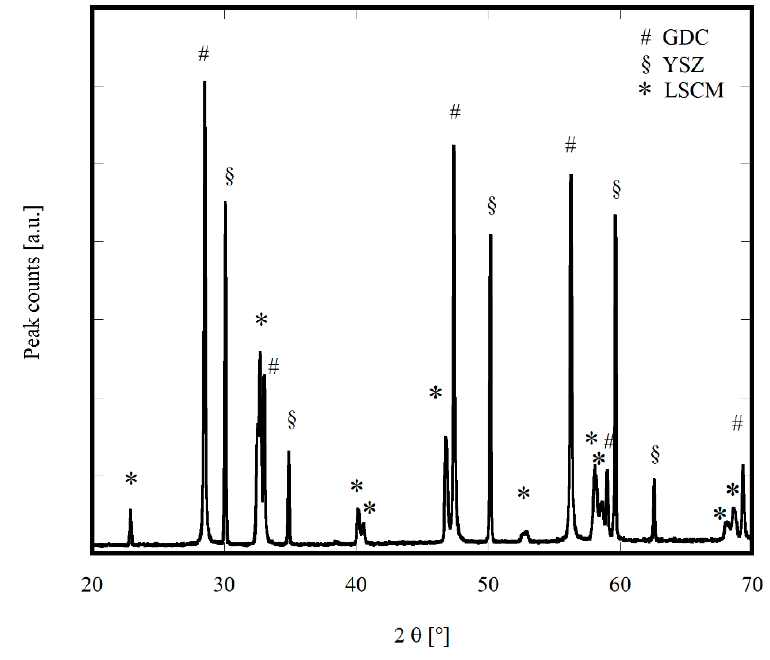
Figure 2. XRD pattern of the LSCM/GDCW infiltrated electrode.